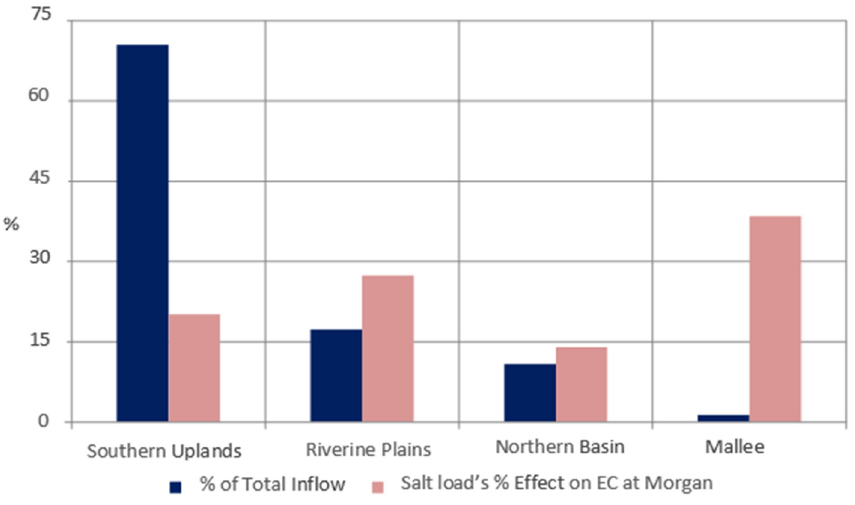
Figure 4. Average contributions of flow and salt loads to River Murray salinity at Morgan. See Figure 1 for locations. (Source: [4,35]).